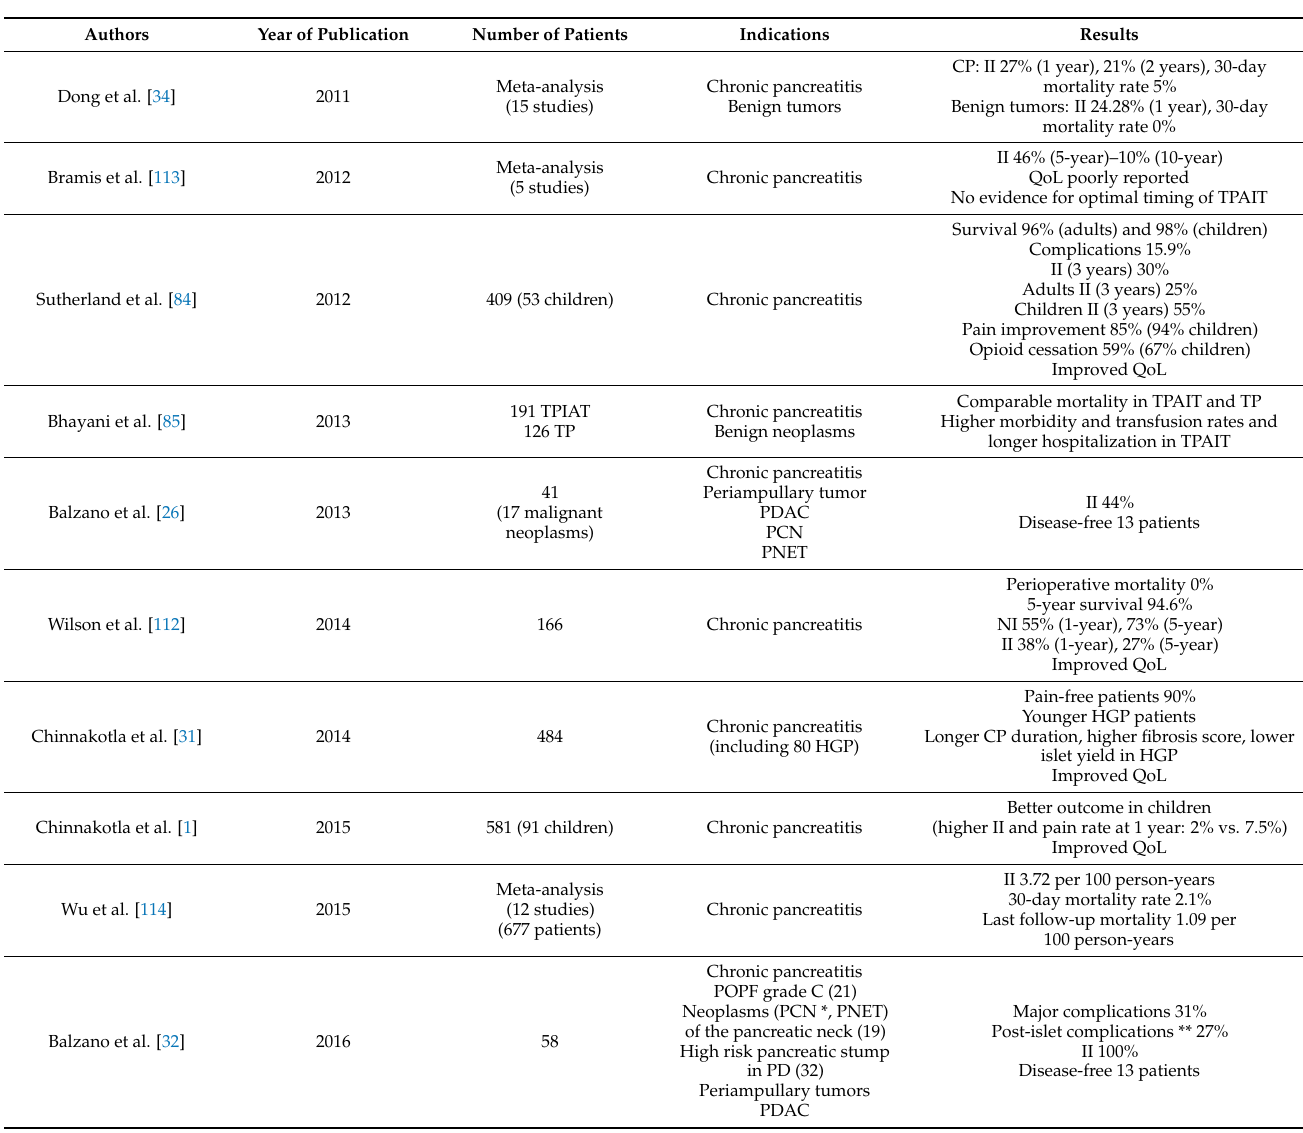
Table 2. Summary of the most important and largest studies on total pancreatectomy with autologous islet